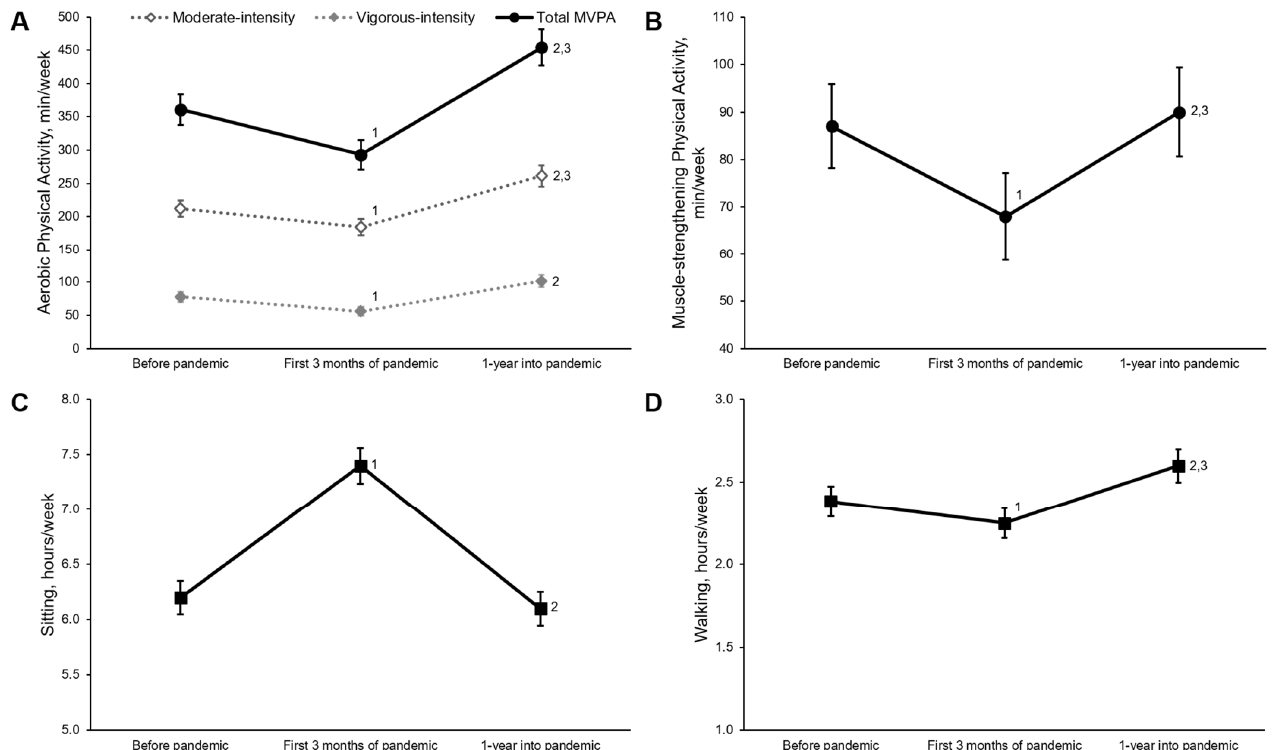
Figure 2. Changes in physical activity and sitting time during the COVID-19 pandemic. Data pre- sented as mean and standard error for moderate-intensity, vigorous-intensity, and total moderate-to- vigorous intensity aerobic physical activity ( A ), muscle-strengthening physical activity ( B ), sitting ( C ), and walking ( D ). All analyses adjusted for age, sex, body-mass index before the COVID-19 pandemic, and number of co-morbidities. 1 Significant difference between before the COVID-19 pandemic and first three months of the COVID-19 pandemic, p < 0.05; 2 Significant difference between first three months of the COVID-19 pandemic and one year into the COVID-19 pandemic, p < 0.05; 3 Significant difference between before the COVID-19 pandemic and one year into the COVID-19 pandemic, p < 0.05. Sample sizes are 344, 355, and 336 for moderate-intensity, vigorous-intensity and total MVPA, respectively; 315 for muscle-strengthening physical activity; 360 for sitting time and 353 for walking.